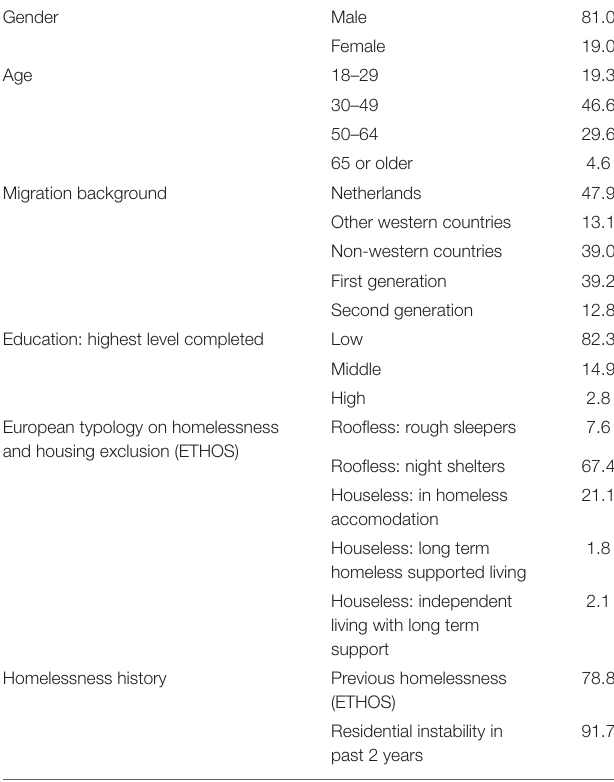
TABLE 1 | Background characteristics of the sample (in